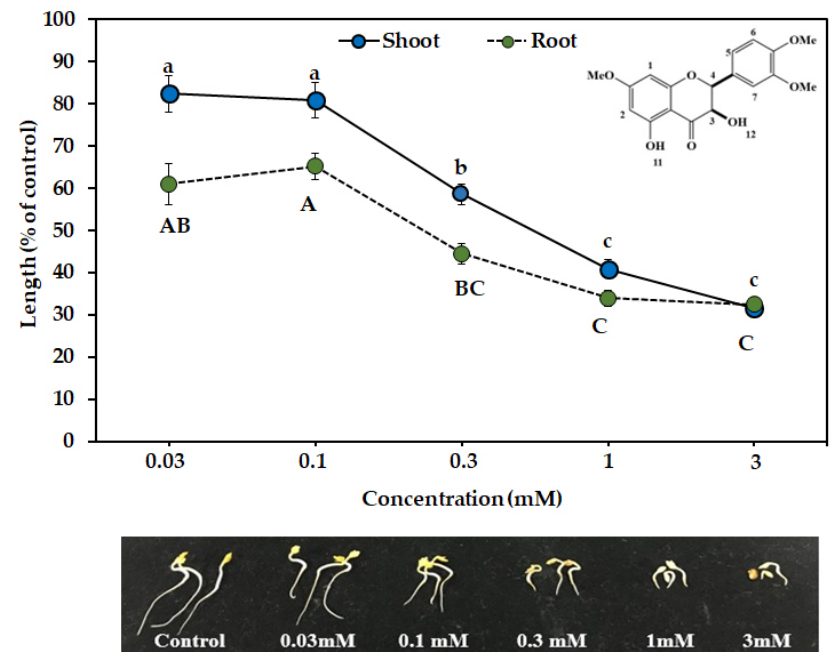
Figure 4. The effect of compound 1 (7,4′,5′ -tri- O -methyl dihydroquercetin) on the shoot and root growth of the cress seedling. Data are shown as means ± standard errors. Different letters indicate significant differences between treatments for shoots (small letters) and roots (capital letters) (Tukey’s HSD, p ≤ 0.05).